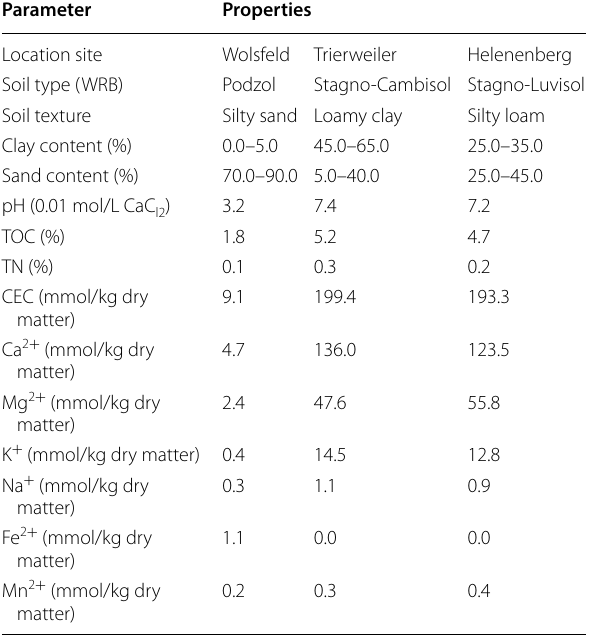
Table 1 Characterization of the test